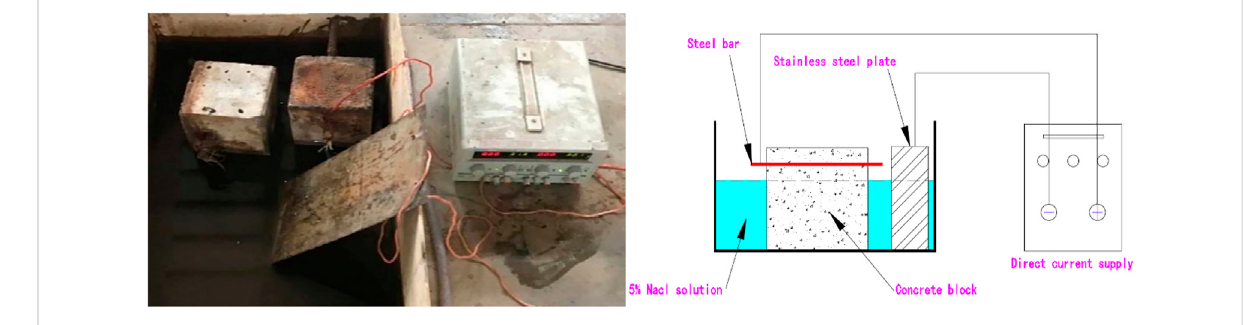
FIGURE 3 Accelerated corrosion test.